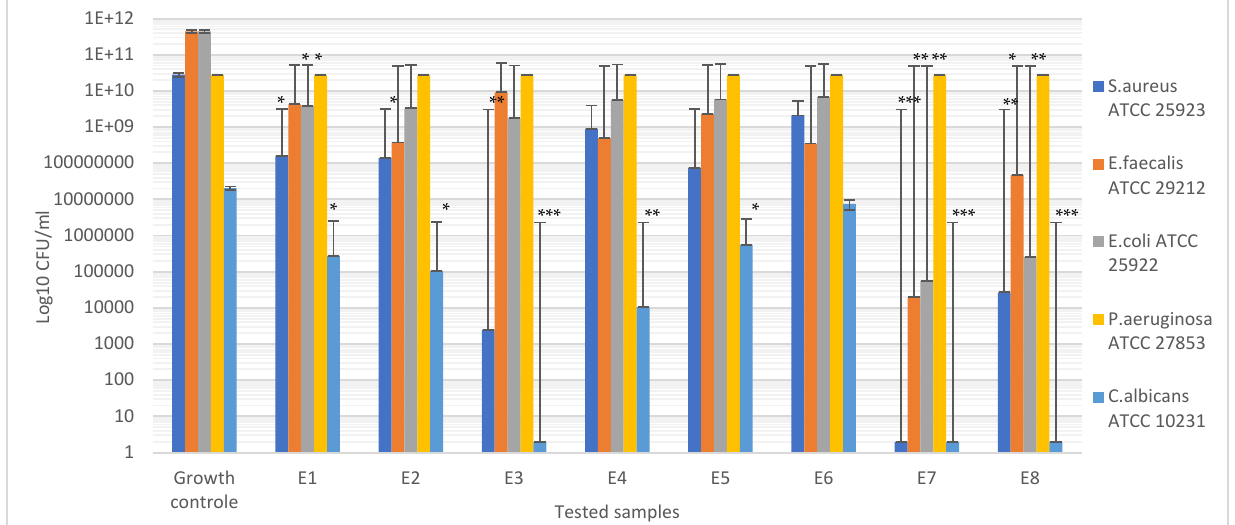
Figure 13. Graphical representation of the CFU/mL values evaluating the inhibitory effect. Significant evidence of the inhibitory effect on the bacterial growth manifested by the tested samples was noted as * for p < 0.05, ** for p < 0.01, and *** for p > 0.001.